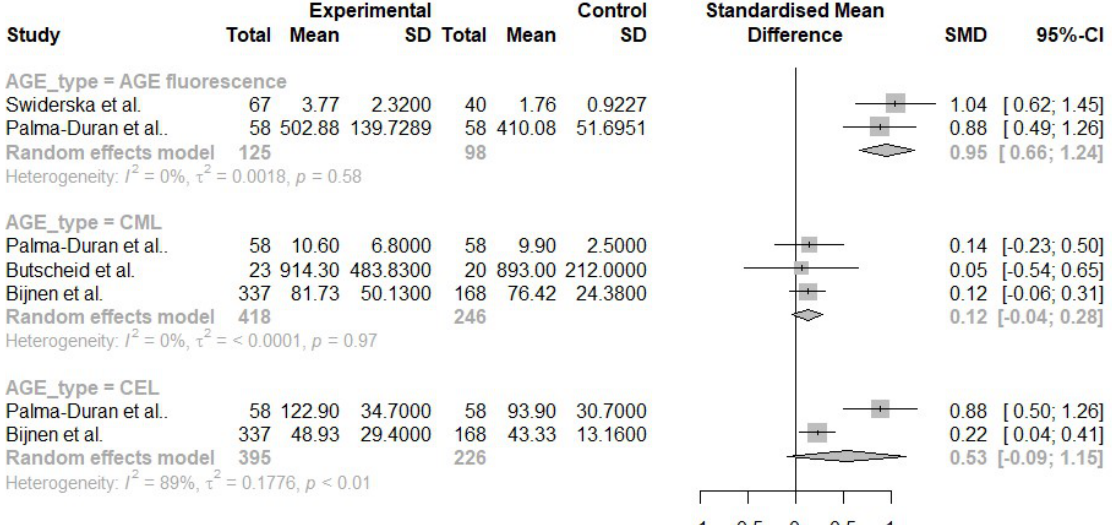
Figure 4. Pairwise comparisons of serum AGE (CML) levels between patients with ALD and healthy controls [38,39].